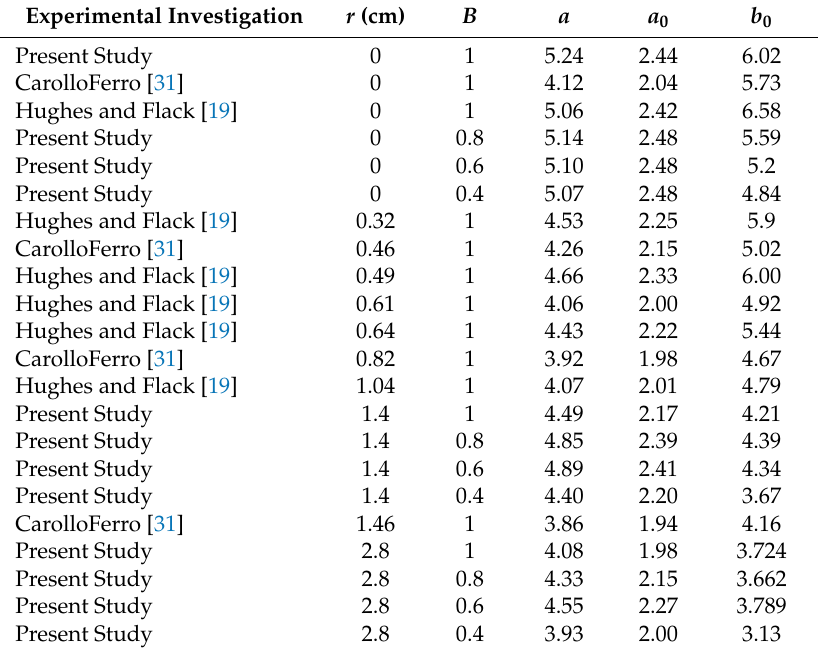
Table 4. Values of coefficients of a , a 0 and b 0 calculated from all experimental data and obtained by previous studies.